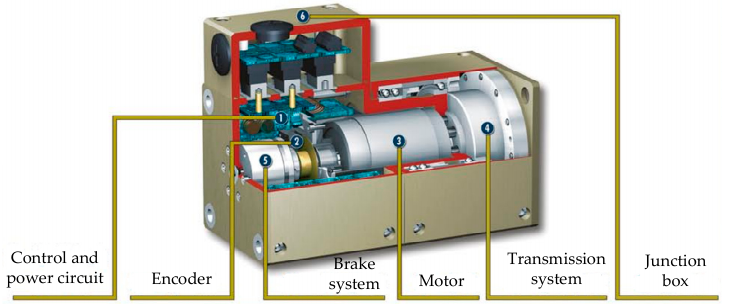
Figure 5. Redundant range diagram.